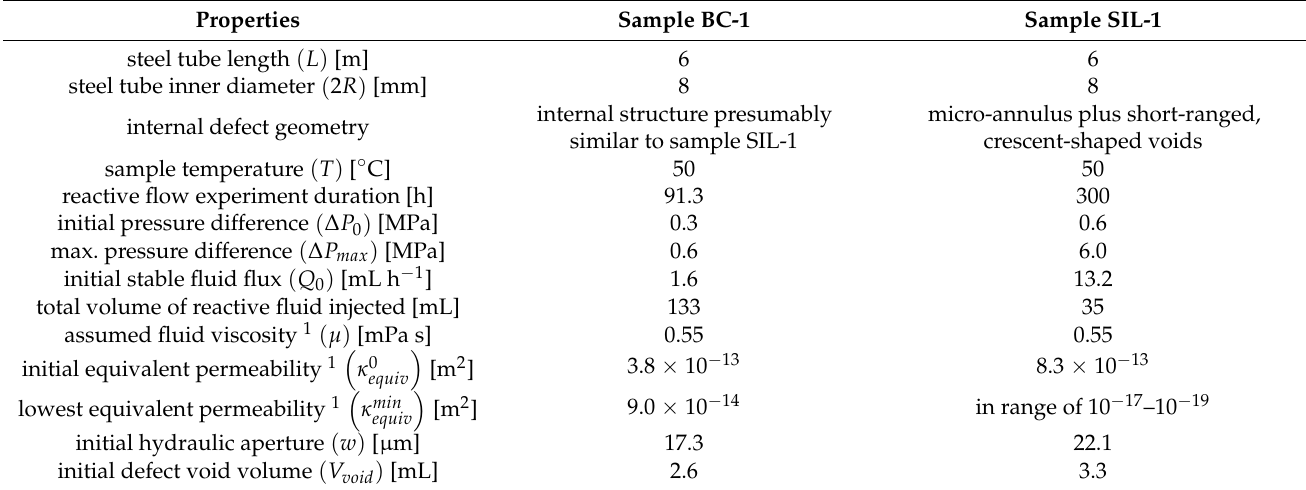
Table 1. Overview of performed experiments and